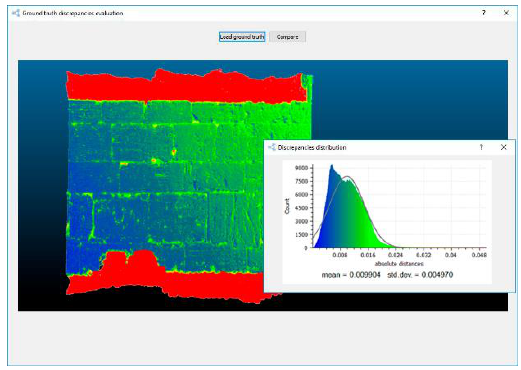
Figure 9. Comparison between the dense matching provided by GRAPHOS and the ground truth obtained with a laser scanner.